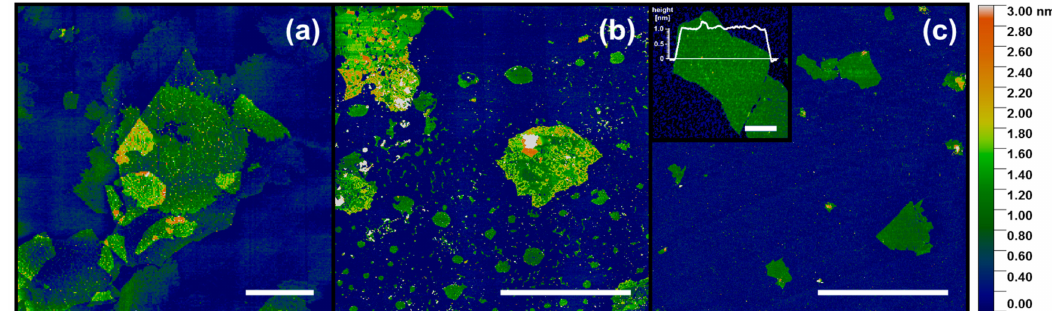
Figure 1. AFM topography of graphene oxide: ( a ) large flakes, ( b ) medium flakes, ( c ) small flakes, Inset: a single-layer graphene oxide flake with a marked height profile. Scale bars: ( a – c ): 10 µ m; Inset: 0.5 µ m. To estimate the graphene oxide oxidation level, the CHNS + O was conducted (Table 1).